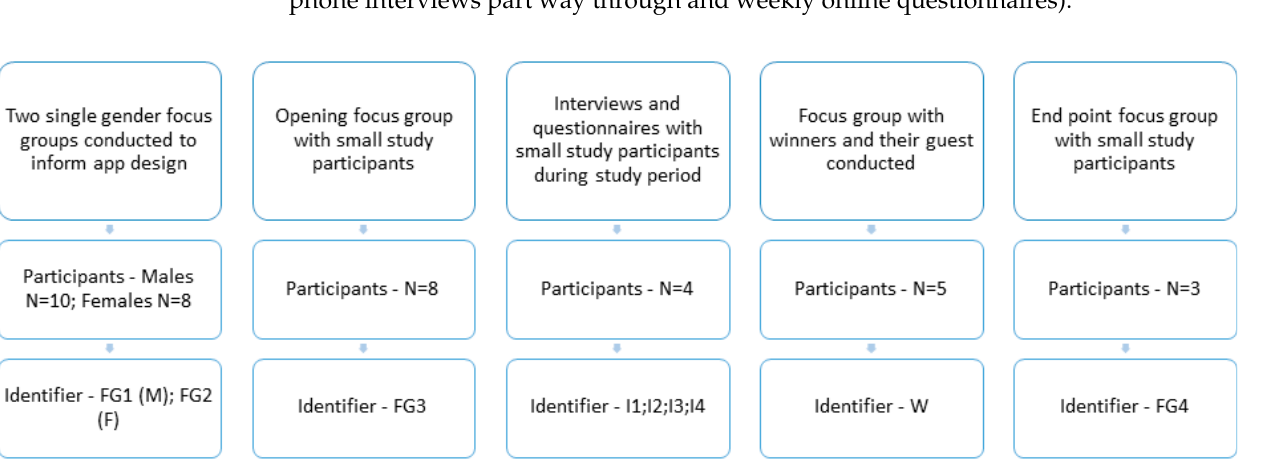
Figure 2. The process of data collection through the study period and the participant